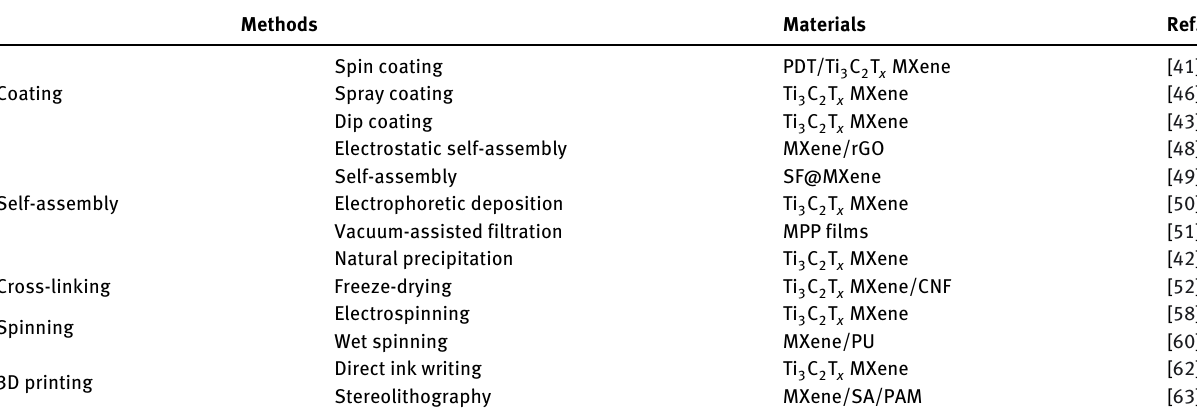
Table 1: Preparation methods of MXenes-based flexible materials.